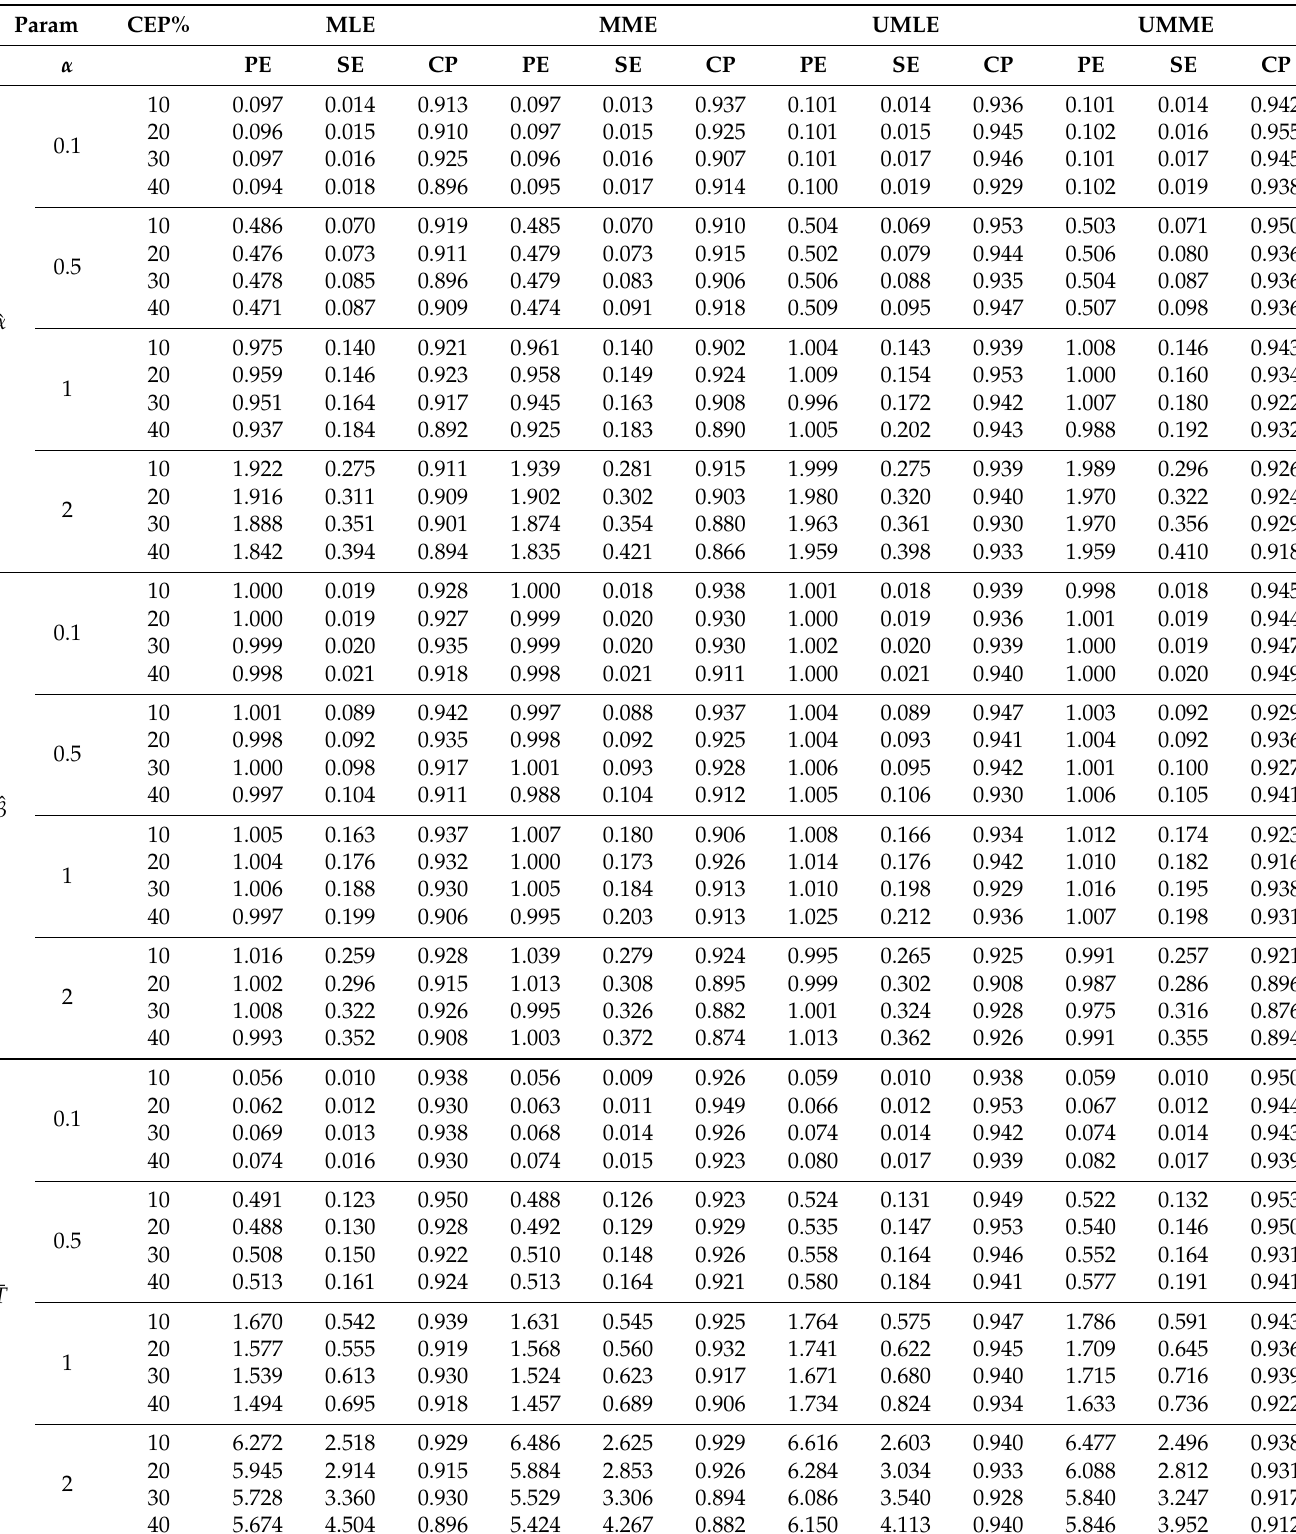
Table A3. Mean and standard error of the point estimates and probability coverages of 95% confidence intervals based on Monte-Carlo simulation ( n =